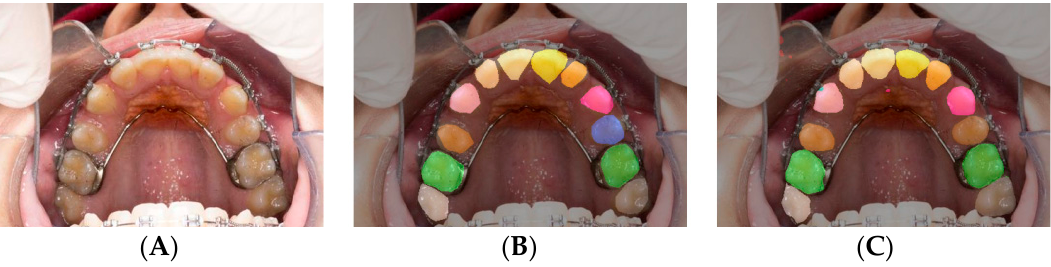
Figure 9. Mislabeling due to missing teeth: The original image ( A ); the ground truth label ( B ); the image prediction from the model ( C ).